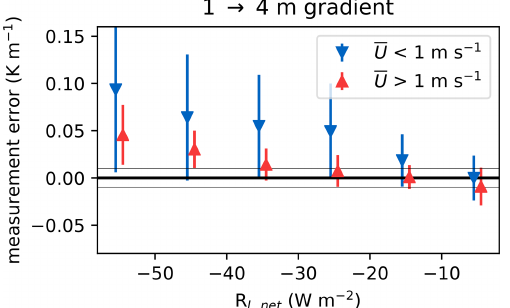
Figure B1. Overview of the measurement setup at CESAR.